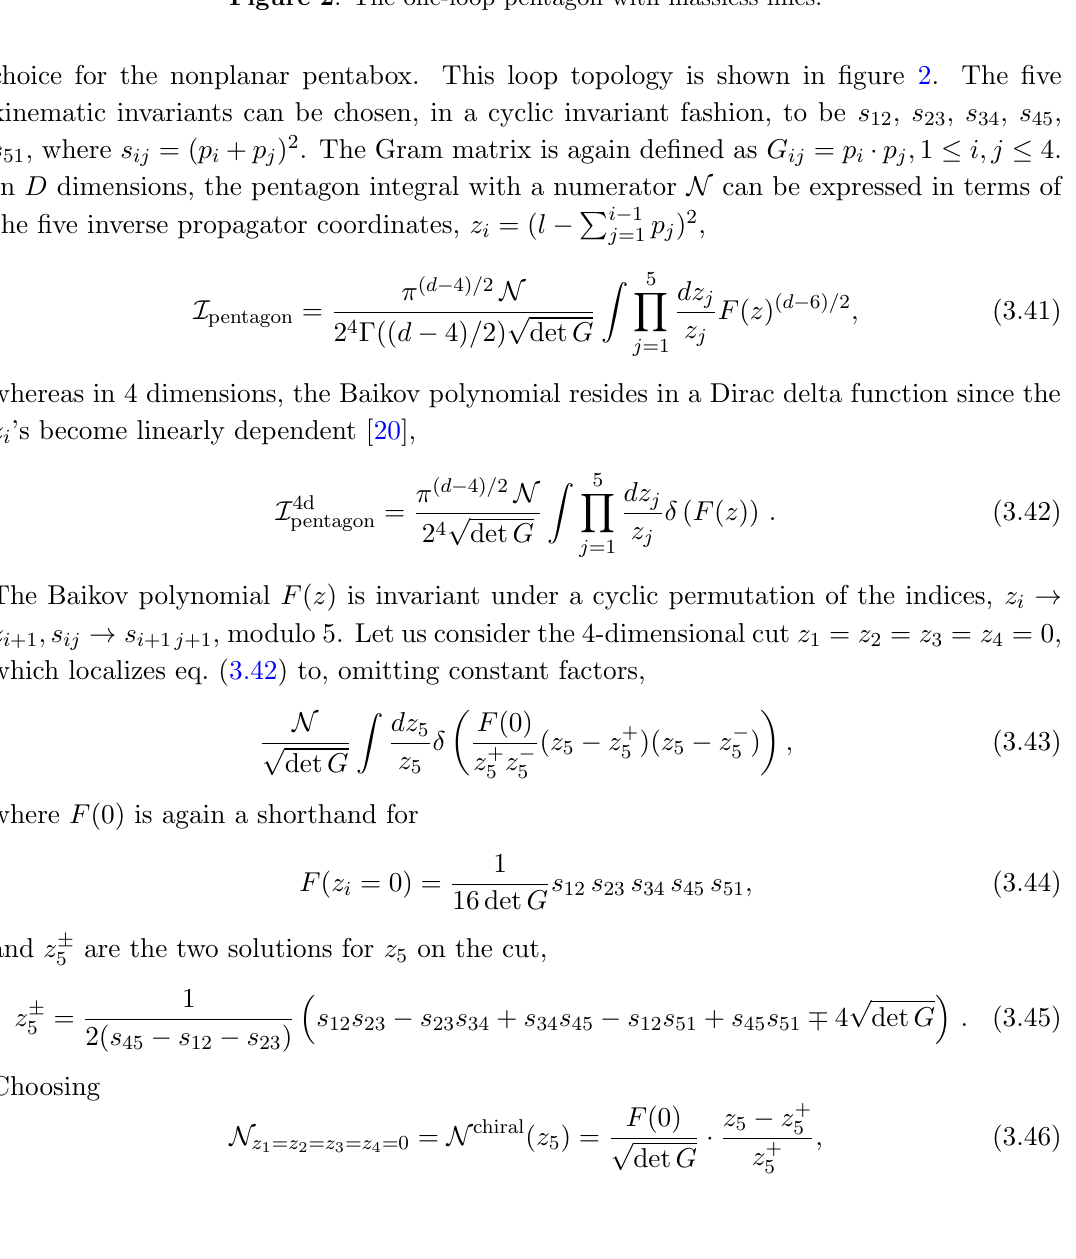
Figure 2 . The one-loop pentagon with massless